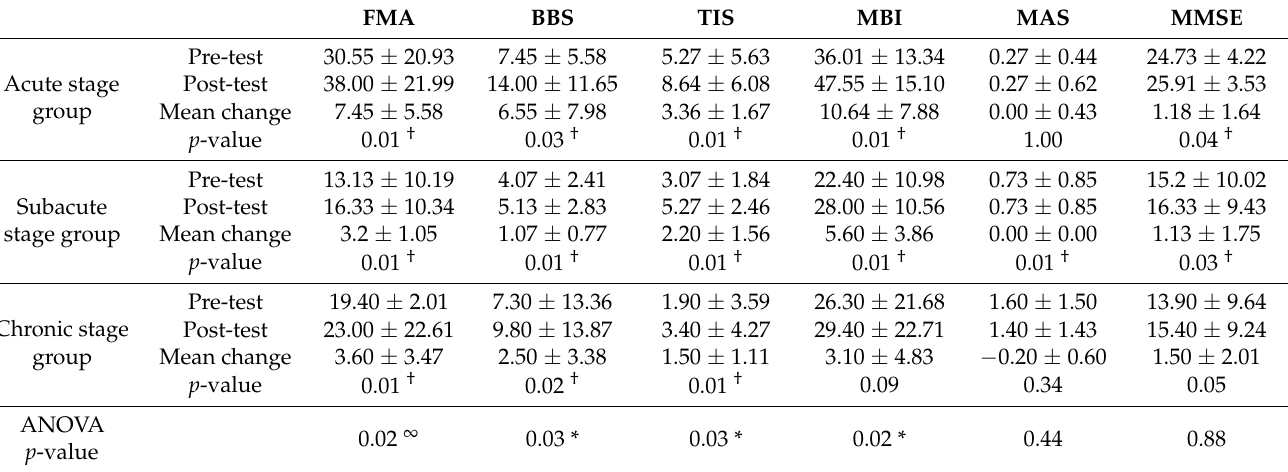
Table 2. Clinical outcome measure differences between before and after Walkbot RAGT interventions in the acute, subacute, and chronic stages of stroke ( N =